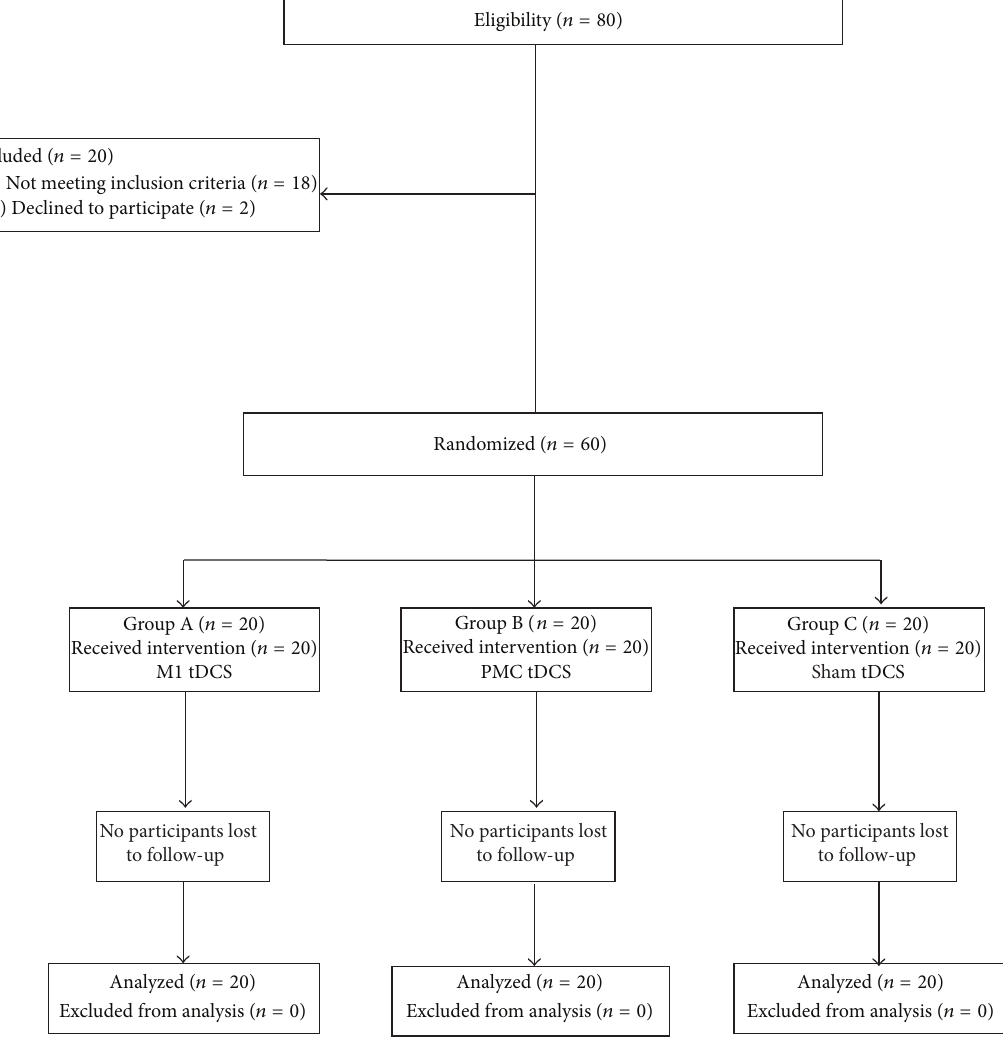
Figure 1: Flowchart of study based on Consolidated Standards of Reporting Trials